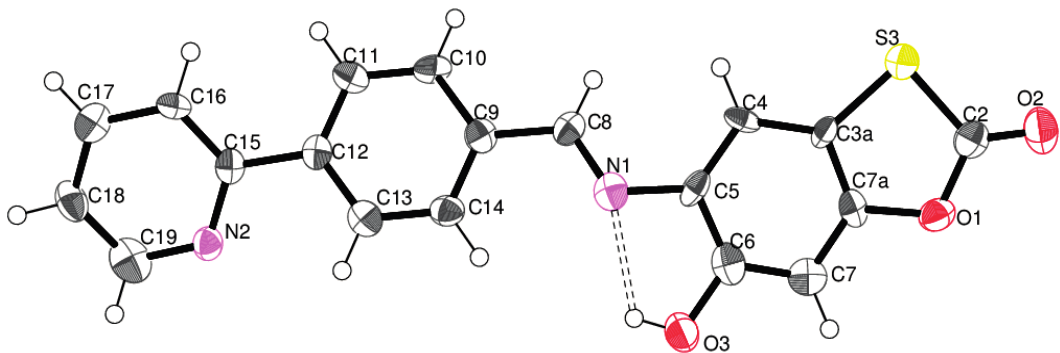
Figure 1. Atom arrangements and numbering scheme for 4q